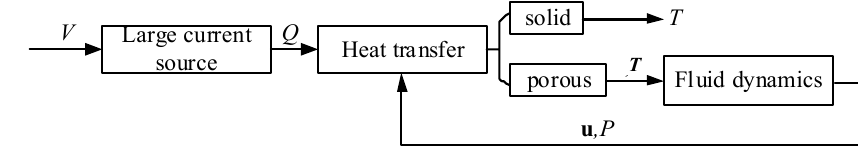
Figure 7. Multi-physics coupling.